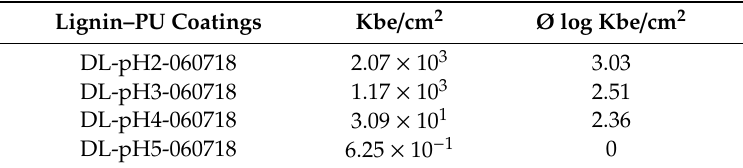
against S. aureus